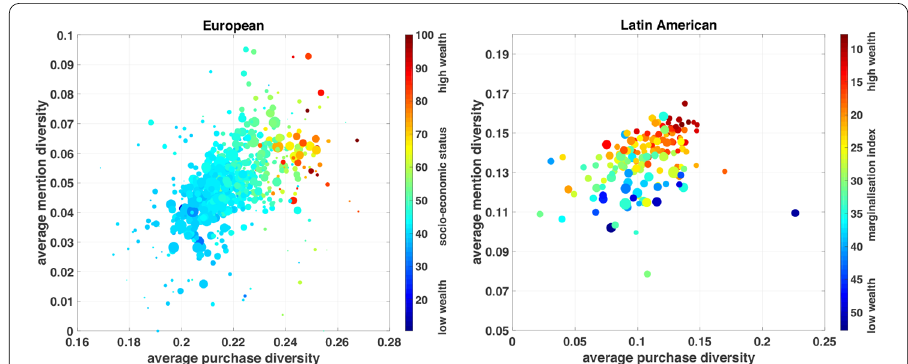
Figure 1 Purchase interactions among some of the neighborhoods in the European metropolitan area. Each neighborhood is shown as an area on the map (panel ( A )) and as a node in a graph (panel ( B )), and it is in both cases color-coded by its socio-economic status. Each curve in both panels represents an interaction between a pair of neighborhoods, and it is color-coded by the number of purchases made by residents of one neighborhood in another. The directions of the curves are represented by their convexity: curves of convex shape represent interactions from the left end point to the right end point, while those of concave shape represent interactions from right to